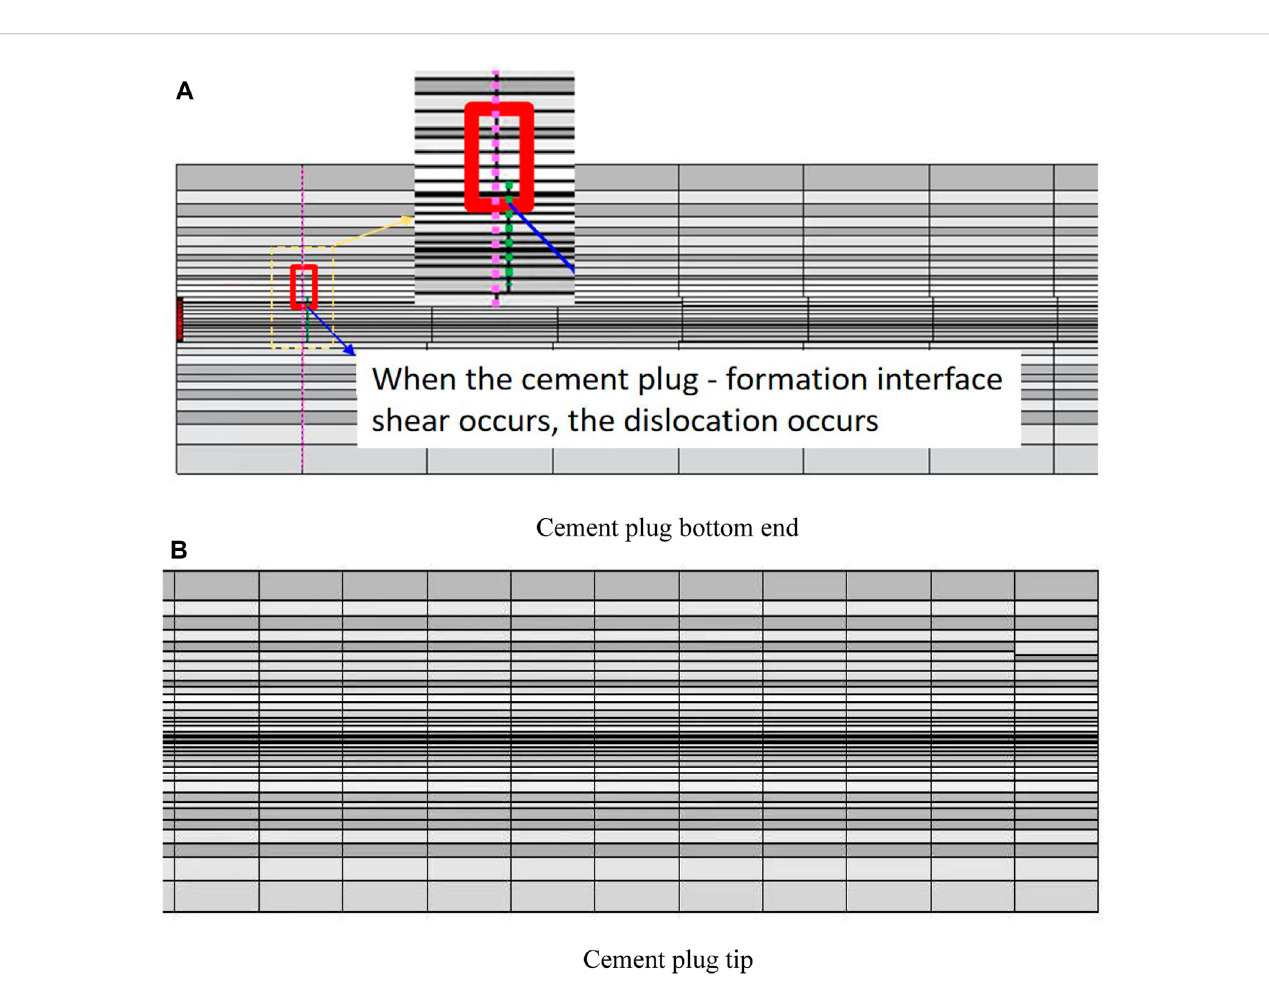
FIGURE 6 Schematic diagram of relative position after shear failure of cement plug-formation interface. (A) The simulation diagram of the relative position of the bottom of the cement plug after the shear failure of the cement plug-formation interface. (B) The simulation diagram of the relative position of the top of the cement plug after the shear failure of the cement plug-formation